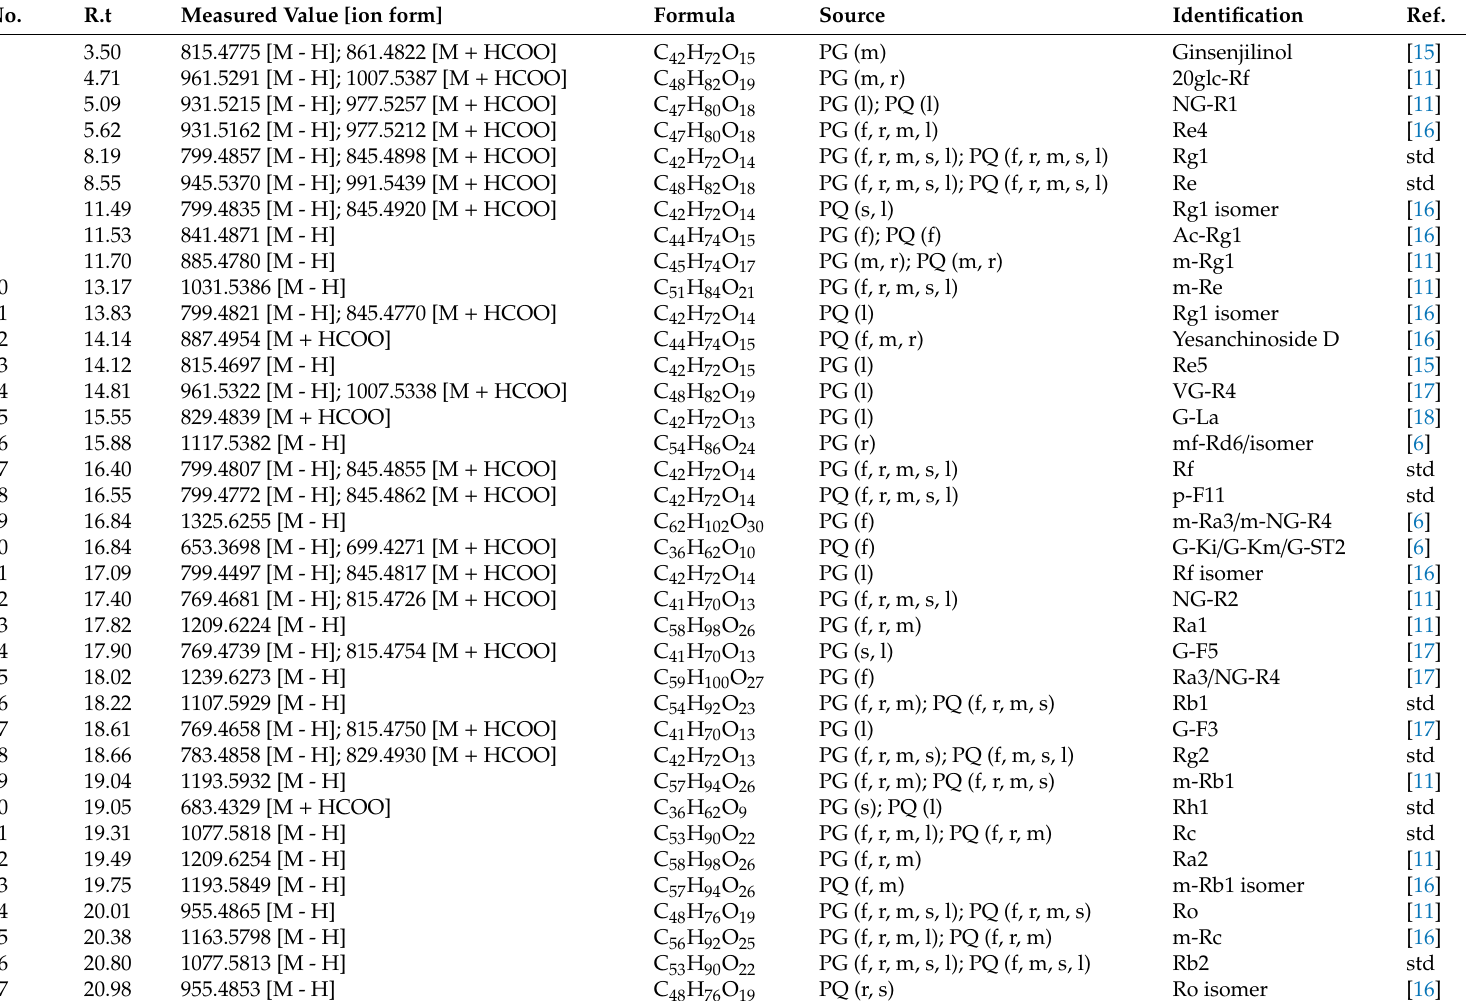
Table 1. The ginsenosides identified from various parts of New Zealand-grown Panax ginseng (PG) and Panax quinquefolium L. (PQ).